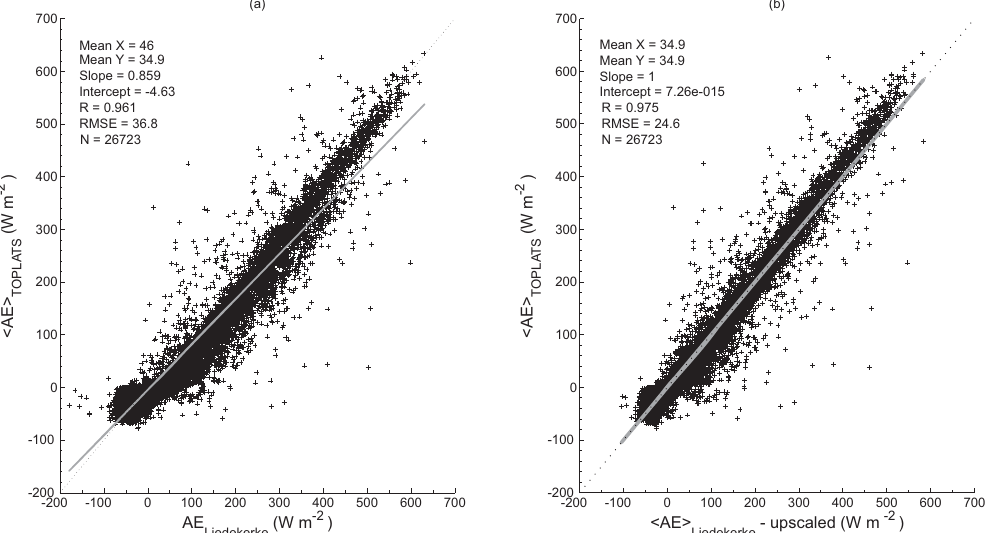
Fig. 2. Comparison between AE Liedekerke and < AE > TOPLATS (a) and comparison between upscaled values of AE Liedekerke for the catch- ment according to the monthly statistics as given in Table 2 (b)